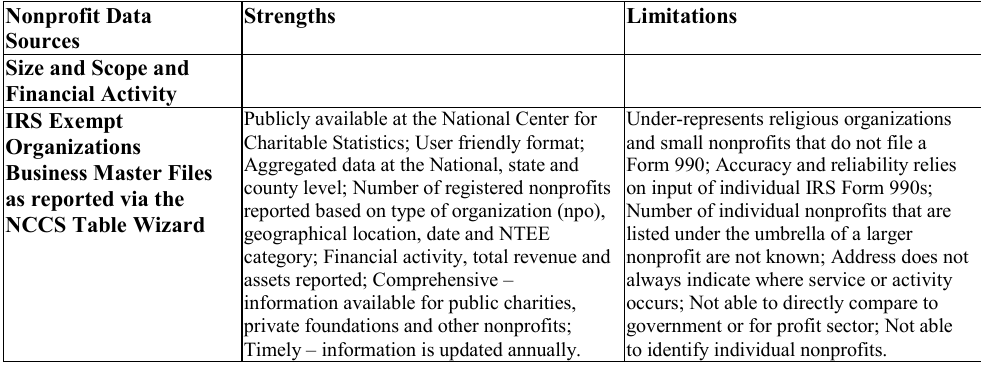
Table 1. Strengths and Limitations of Nonprofit Data